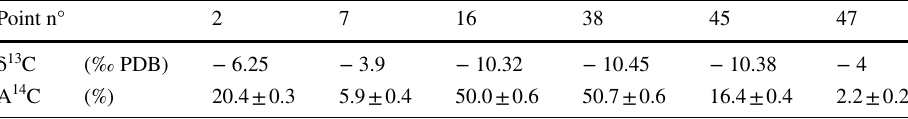
Table 4 Isotopic composition